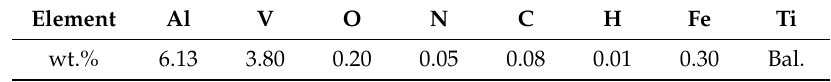
Table 1. Chemical composition of SLM Ti-6Al-4V (wt.%).